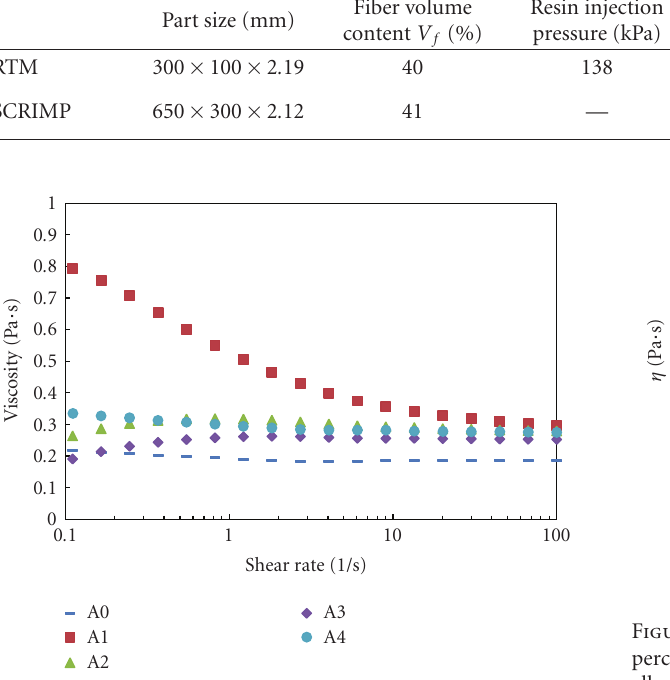
Figure 5: Shear viscosity sweep at 23 ◦ C for 3%wt C30B nanoclay dispersed in petroleum-based resin R937 by di ff erent methods.